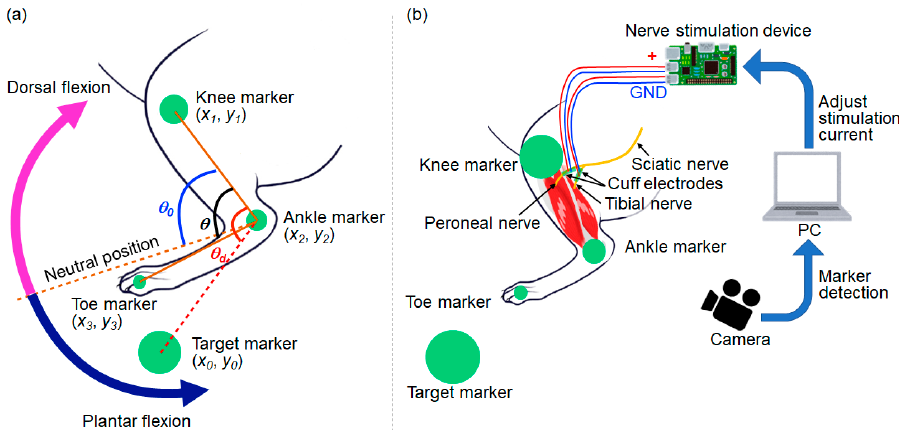
Figure 10. Experimental setup for visual feedback control of the rat ankle angle: ( a ) A schematic of the markers placed on a rat leg for detecting the ankle angle and the target angle; ( b ) A schematic of the experimental system for visual feedback control.